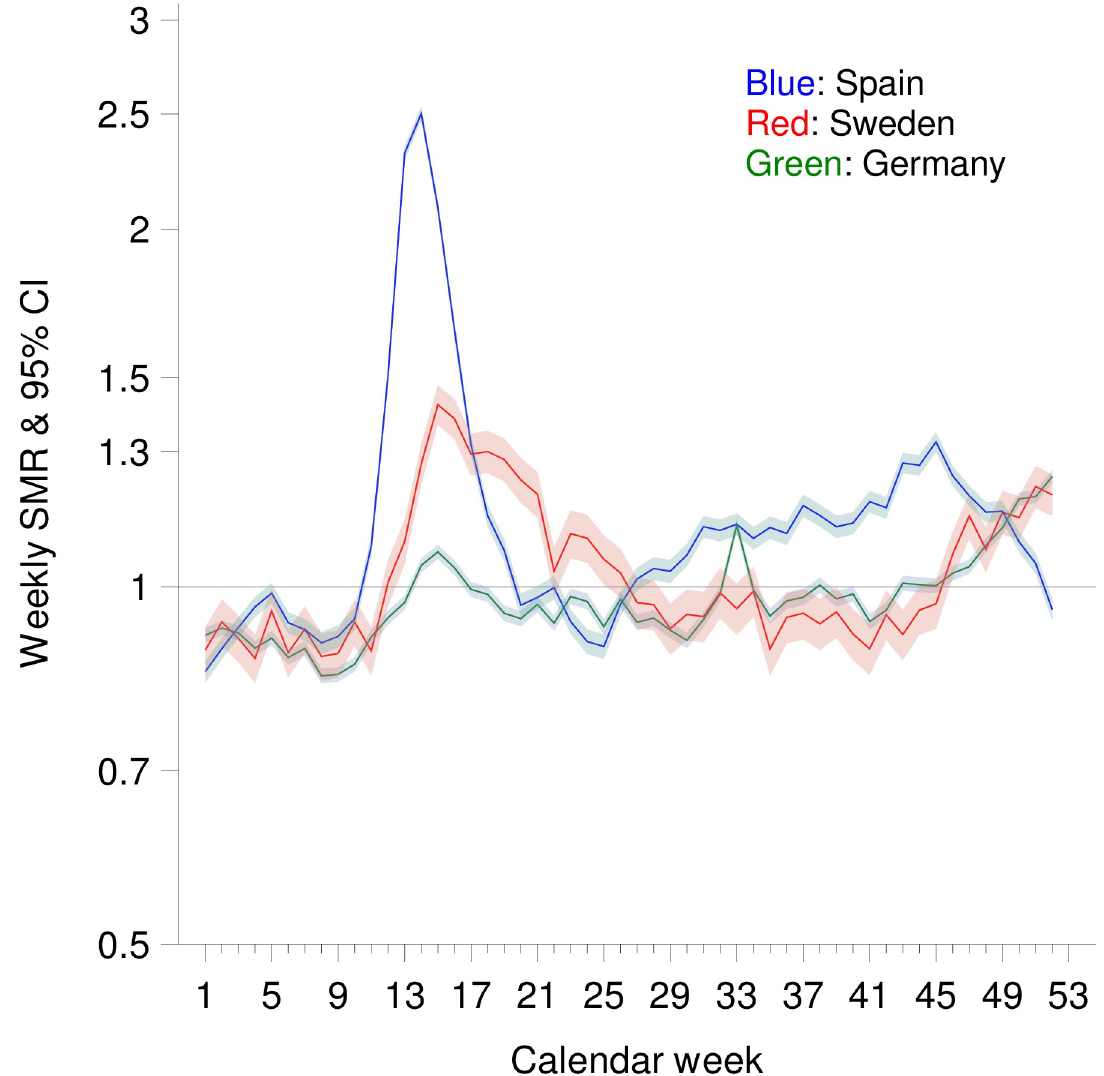
Fig 1. Weekly standardized mortality ratio (SMR) by calendar week in Spain, Germany and Sweden (no consideration of life expectancy).